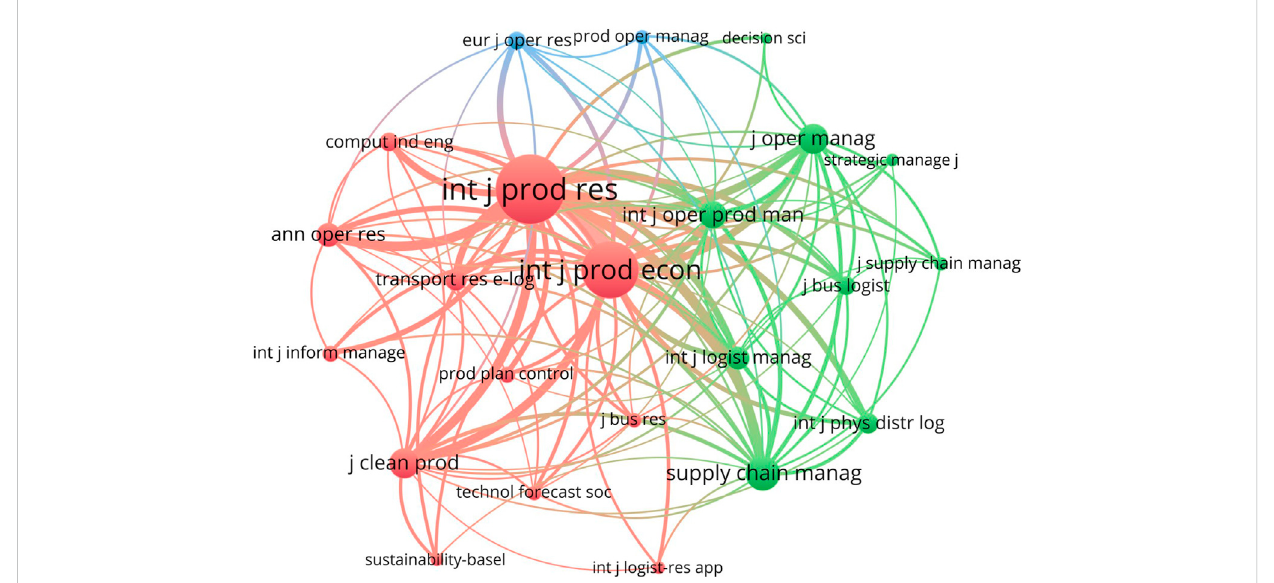
FIGURE 2 Source co-citation network: top 23 sources with more than 200 citations received from the local data